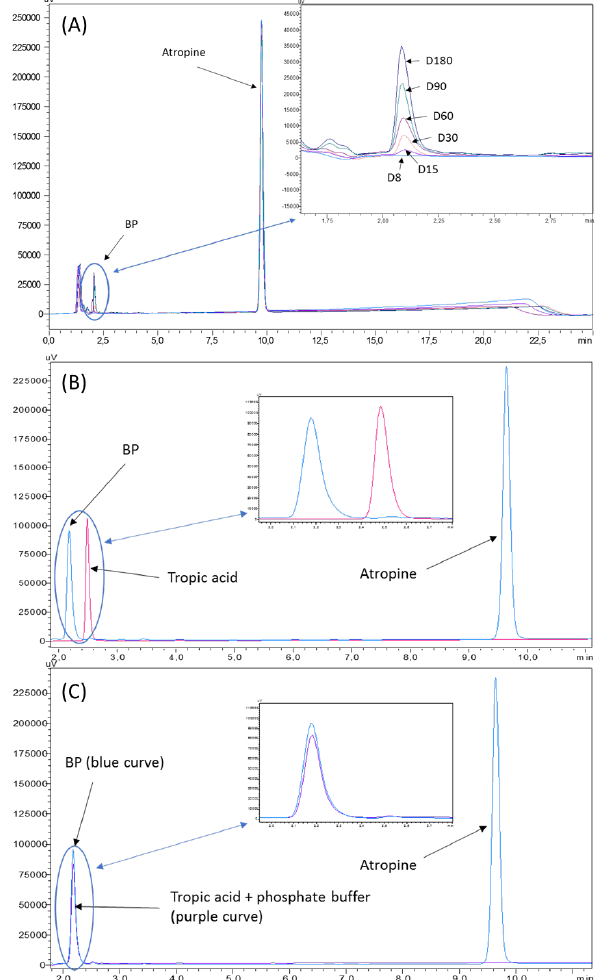
Figure 5. Chromatograms of ( A ) the increased area under curve of the breakdown product, ( B ) superposition of chromatograms of tropic acid diluted in water and an atropine solution containing the breakdown product, and ( C ) superposition of chromatograms of tropic acid diluted in phosphate buffer and an atropine solution containing the breakdown product.